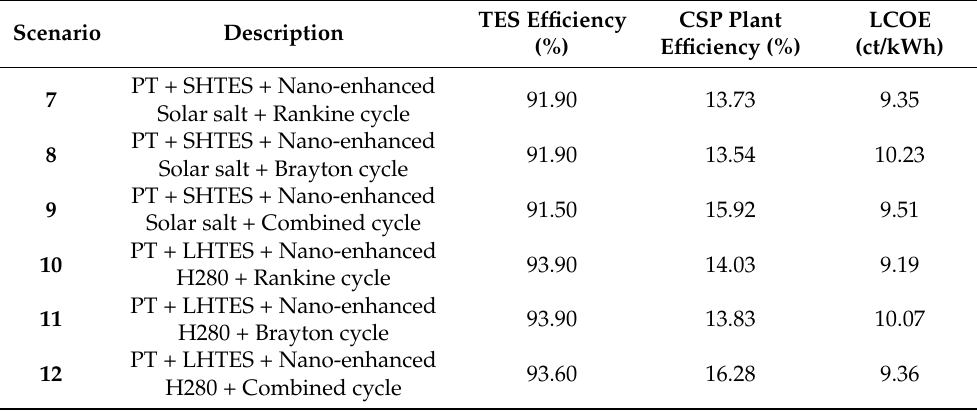
Table 13. LCOE analysis for a parabolic trough plant of 100 MW installed capacity with nano- enhanced storage